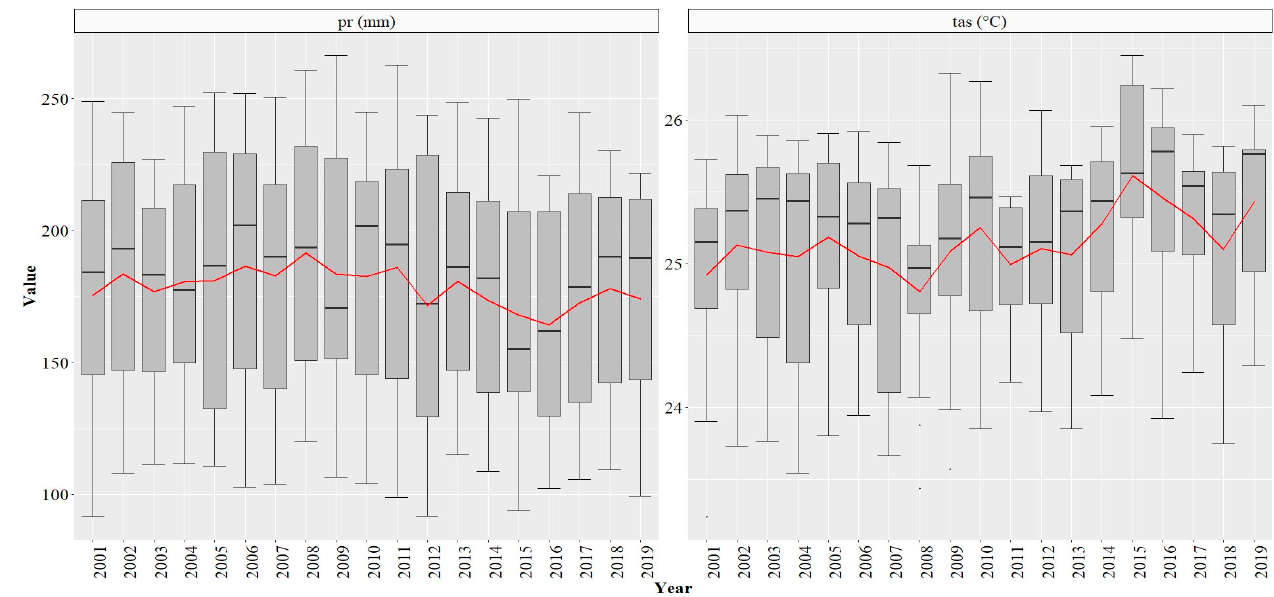
Figure 3. Boxplot statistical analysis: precipitation, pr (mm), in Biome 1 in the AS period 2001–2019, and air temperature, tas (°C), in Biome 1 in the AS period 2001–2019. The red line represents the mean of the time series.